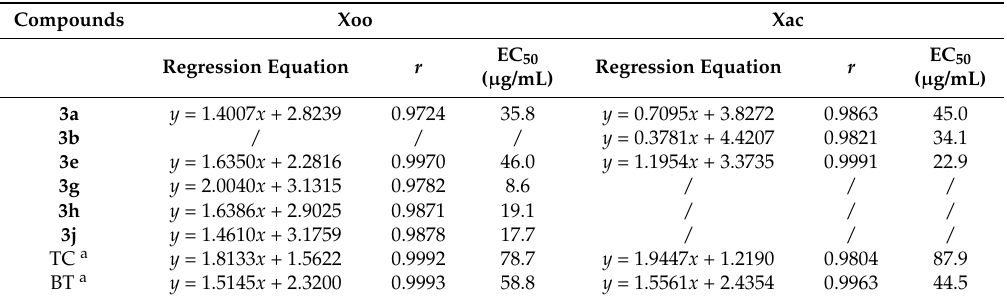
Table 2. Half maximal effective concentration (EC 50 ) values of selected title compounds against Xoo and Xac in